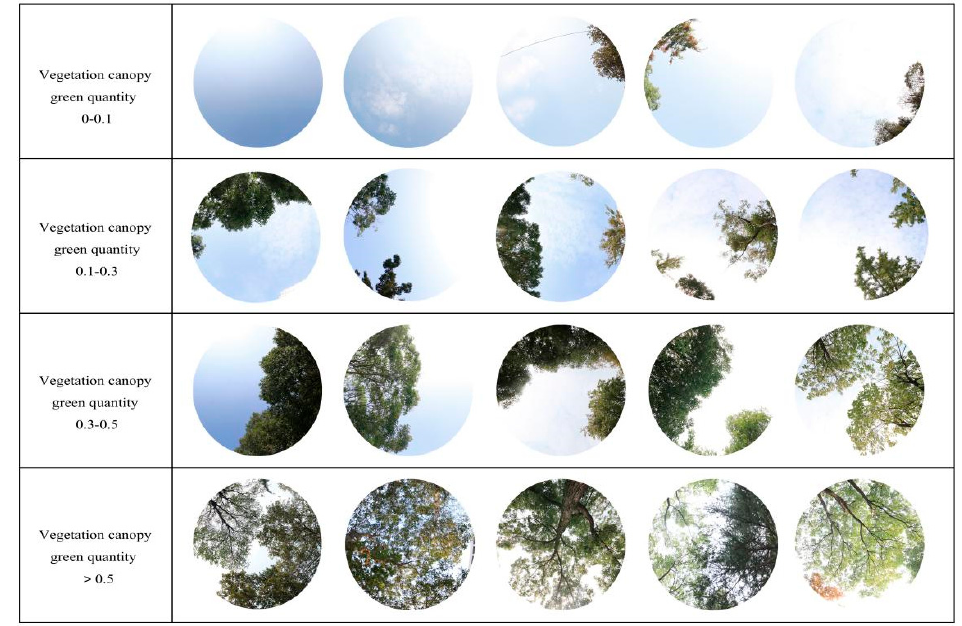
Figure 8. Sample of green quantity collected at different vegetation canopy levels.